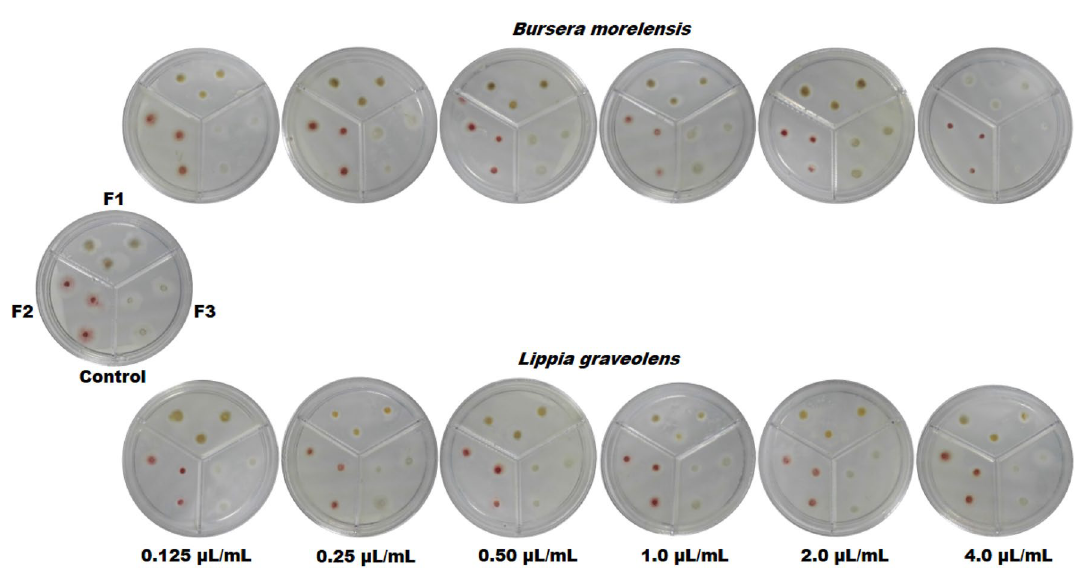
Figure 2. Effect of essential oils on the growth of three Fusarium strains in an in vitro model. Inhibition of radial growth of Fusarium sporotrichioides (F1), Fusarium moniliforme (F2), and Fusarium solani (F3) exposed to Bursera morelensis and Lippia graveolens essential oils at concentrations of 0.125, 0.25, 0.5, 1.0, 2.0 and 4.0 µL/